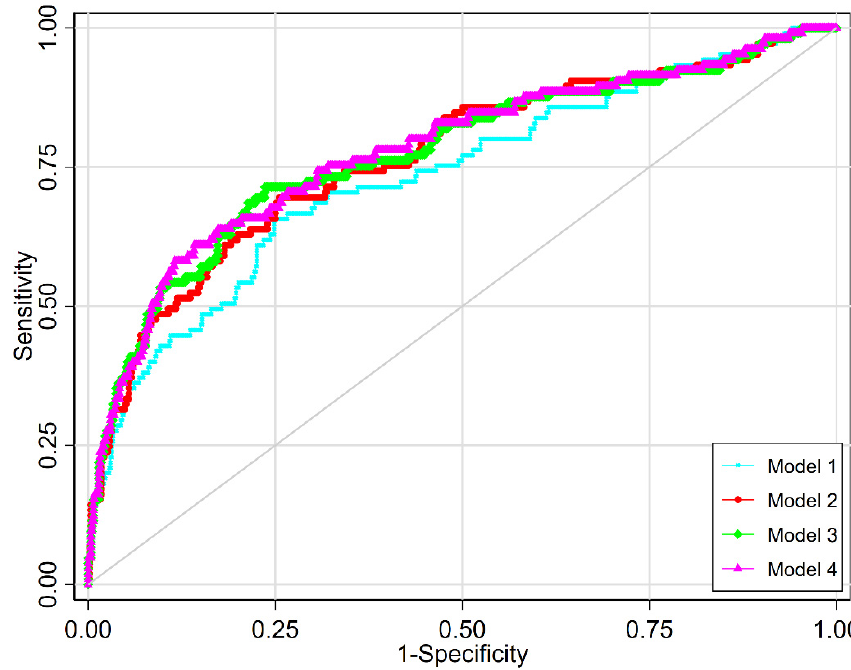
Figure 2. The area under ROC